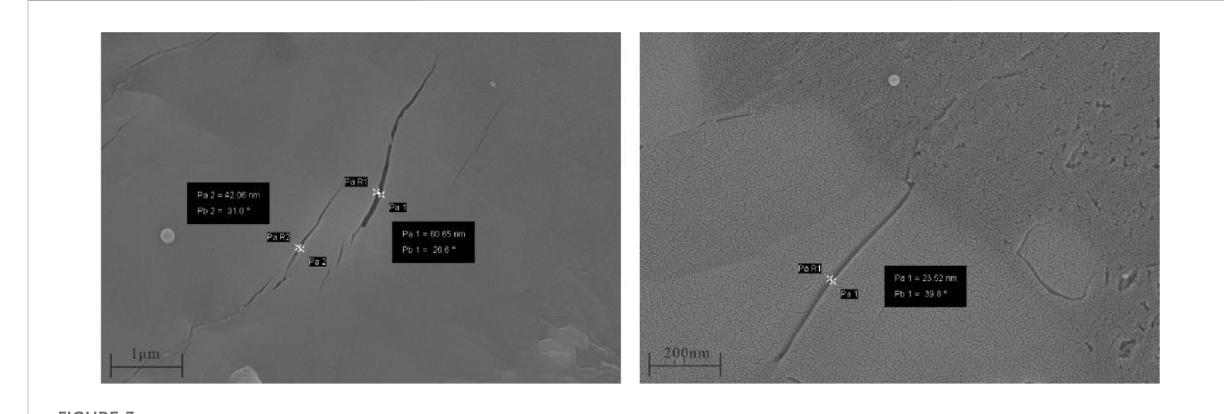
FIGURE 3 Scanning electron